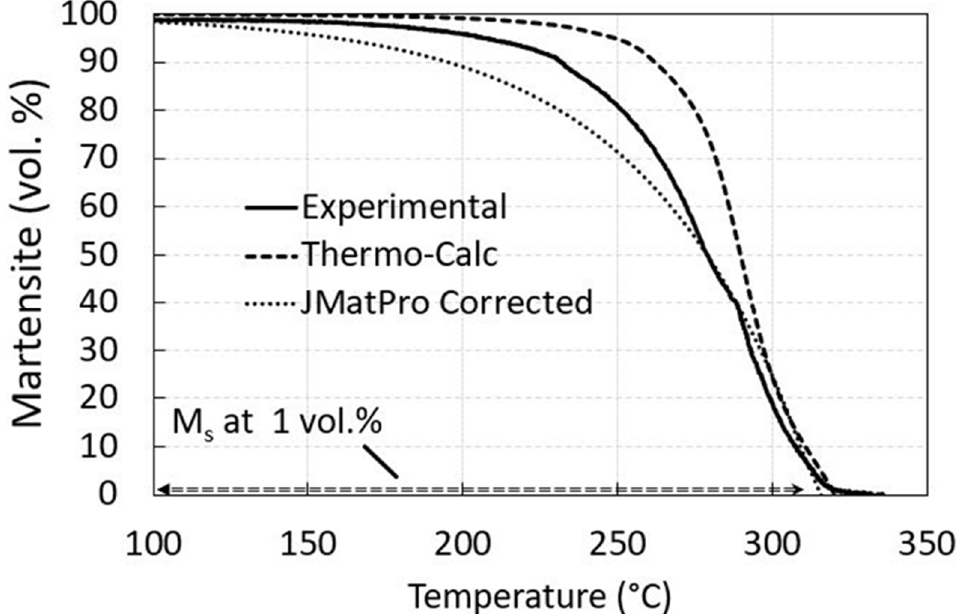
Figure 5. The parabolic martensitic volume fraction development concerning undercooling before isotherms by using JMatPro (Quench properties) and sigmoidal development of martensitic fraction using Thermo-Calc 2020a (TCFE9) and property model calculator based on [22] compared to experimental work.